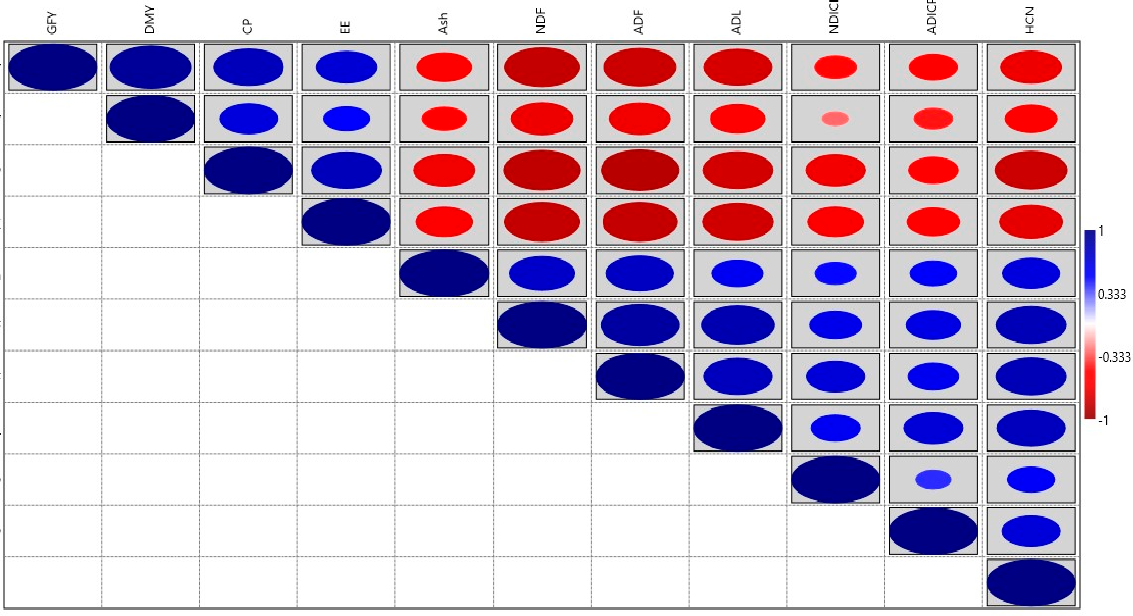
Figure 3. Relationship among green fodder yield (GFY); dry matter yield (DMY) and fodder quality traits [boxed diagonal shows significant ( p ≤ 0.05) association; red and blue colour indicate negative and positive correlations, respectively]. CP: crude protein; EE: ether extract; NDF: neutral detergent fibre; ADF: acid detergent fibre; ADL: acid detergent lignin; NDICP: neutral detergent insoluble crude protein; ADICP: acid detergent insoluble crude protein; HCN: hydrocyanic acid/prussic